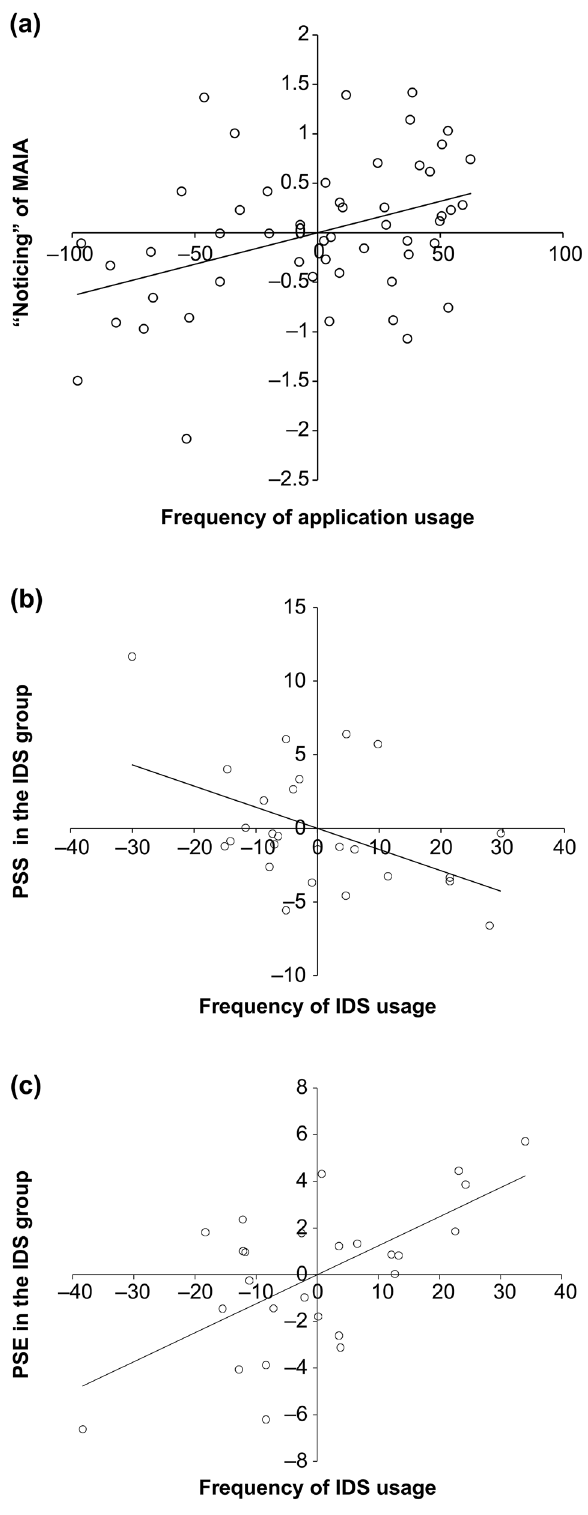
Figure 3. Association between interoceptive sensibility and psychological variables and the frequency of application and IDS usage. ( a ) Associations between changes in “noticing” and the frequency of application usage for the group that used the application ( N = 51), ( b ) associations between PSS and the frequency of IDS usage in the IDS group ( N = 26), ( c ) associations between PSE and the frequency of IDS usage in the IDS group ( N = 26). The lines are regression lines. The scores shown are regression residuals, which control for the baseline variation in “noticing” during Session 1 and are distributed around a mean value of